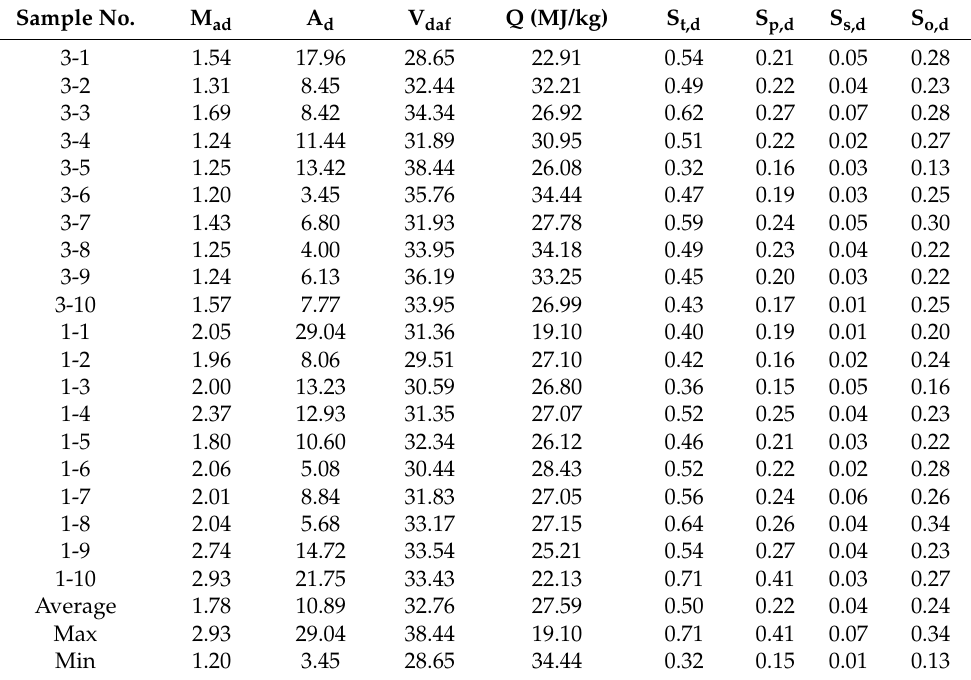
Table 2. Coal quality analysis results of the Shanxi Formation coal in deep Huainan (%). Sample No.